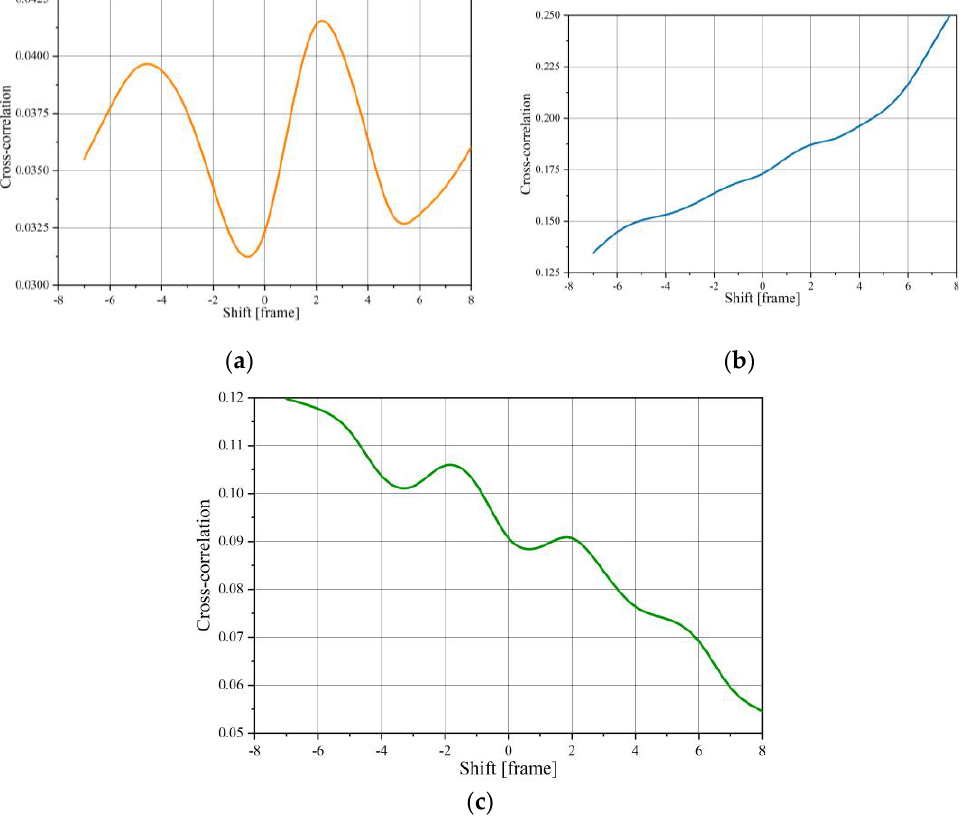
Figure 3. Examples of the correlation function of the normalized changes (see Figure 2) for different